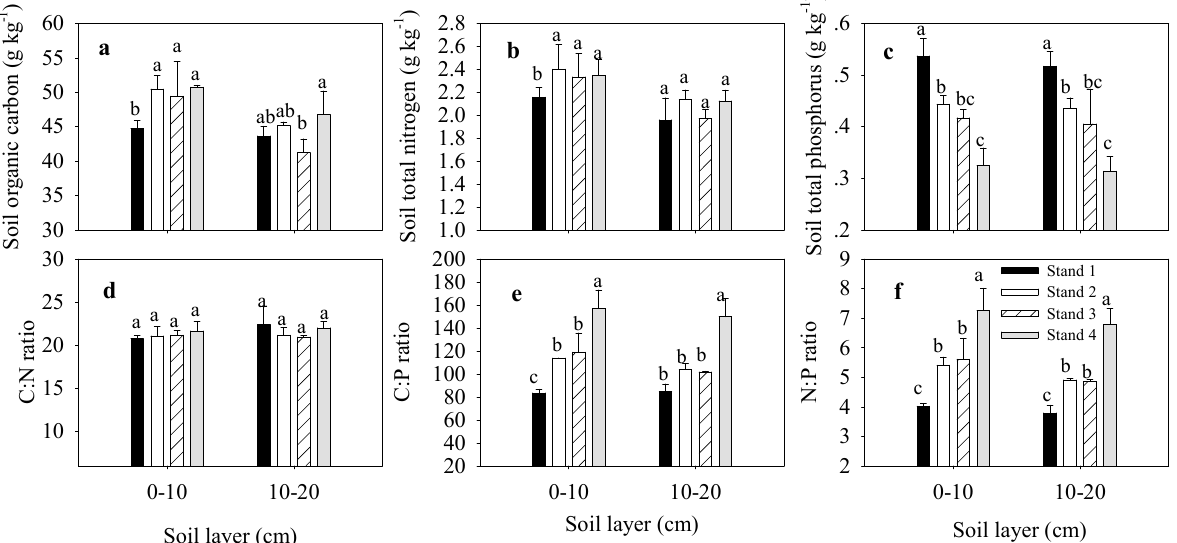
Figure 3. Soil organic C, soil total N and soil total P concentration, as well as their stoichiometry, in moso bamboo stands. The error bar was the mean value of four samplings (mean ± SD, n = 4), and different lowercase letters indicate significant differences between groups ( p ≤ 0.05). a–c, is the concentration of soil organic carbon, soil total nitrogen, soil total phos-